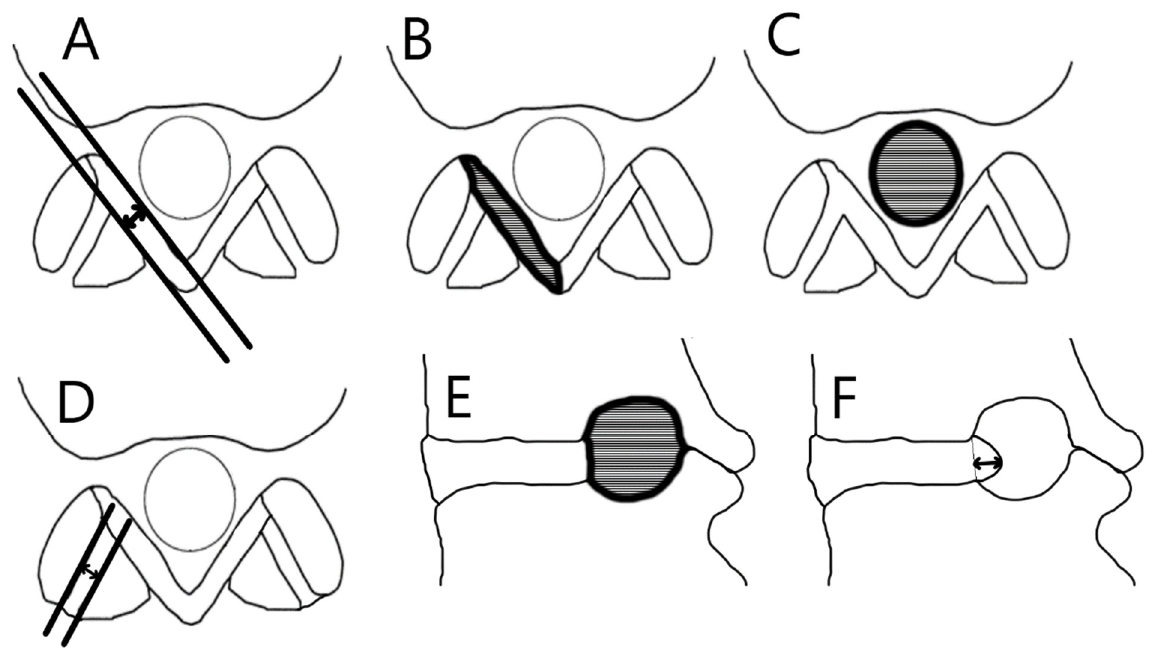
Figure 1. The image analysis. ( A ) Thickness of the ligamentum flavum; ( B ) cross-sectional area of the ligamentum flavum; ( C ) the dural sac cross-sectional area; ( D ) thickness of facet joint effusion; ( E ) the sagittal cross-section area of the vertebral foramen; ( F ) sagittal diameter of the herniated disc.